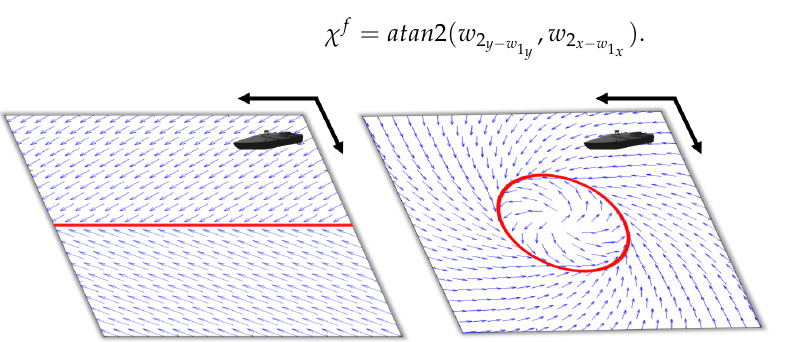
Figure 4. Geometry representing vector field concepts for linear and circular